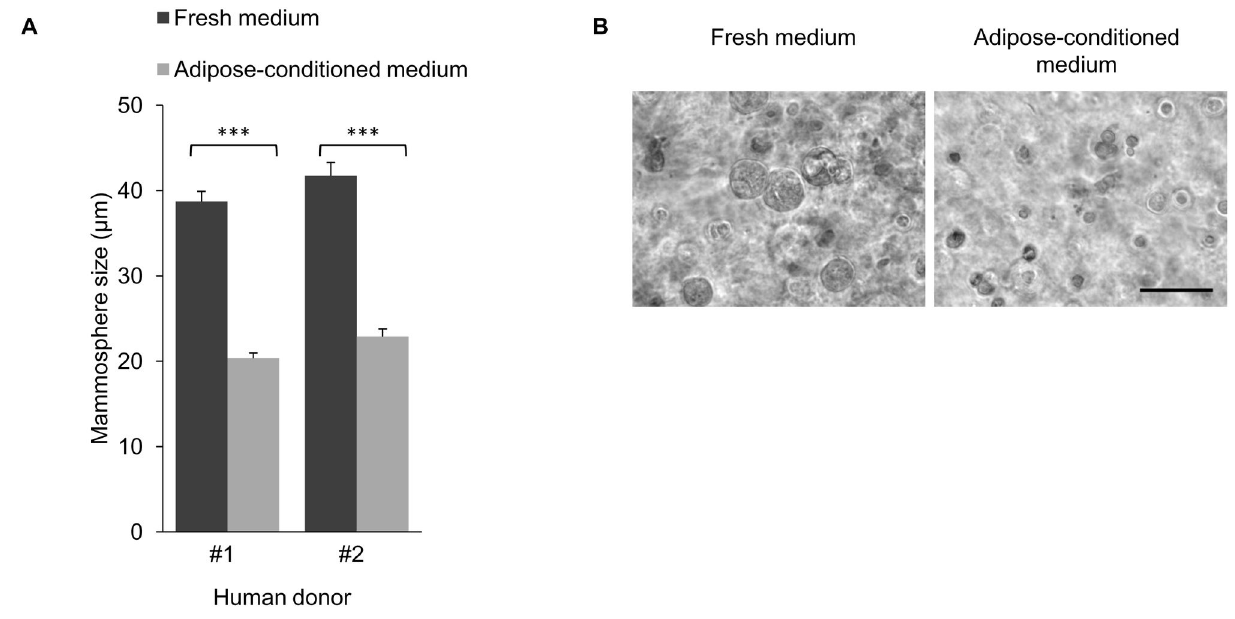
Figure 7. Adipose-conditioned medium suppresses the development of human breast mammospheres in culture. A : Average size of mammospheres formed by hMECs from the breast tissue of two donors after 3 days of culture in fresh or adipocyte- conditioned medium. Columns represent average size ± SEM of 60 mammospheres measured in each group. ***Statistically significant difference ( p ≤ 0.001). B : Light microscopy of representative mammospheres formed by hMECs in 3D Matrigel culture with fresh or adipose-conditioned medium. Bar = 100